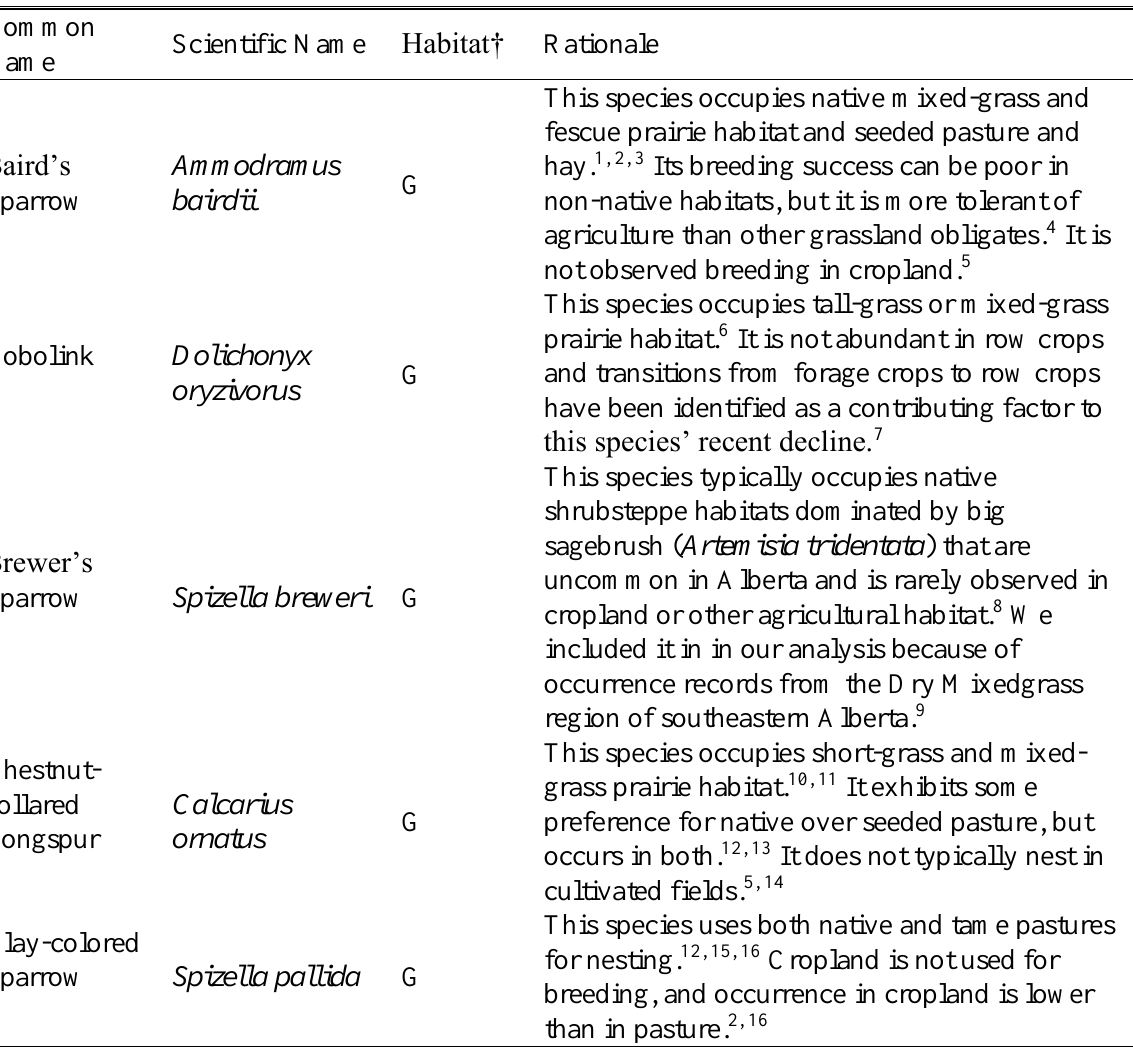
Table A1.1. Breeding habitat classifications and rationale for the 15 grassland songbirds considered in this study (continued on next two